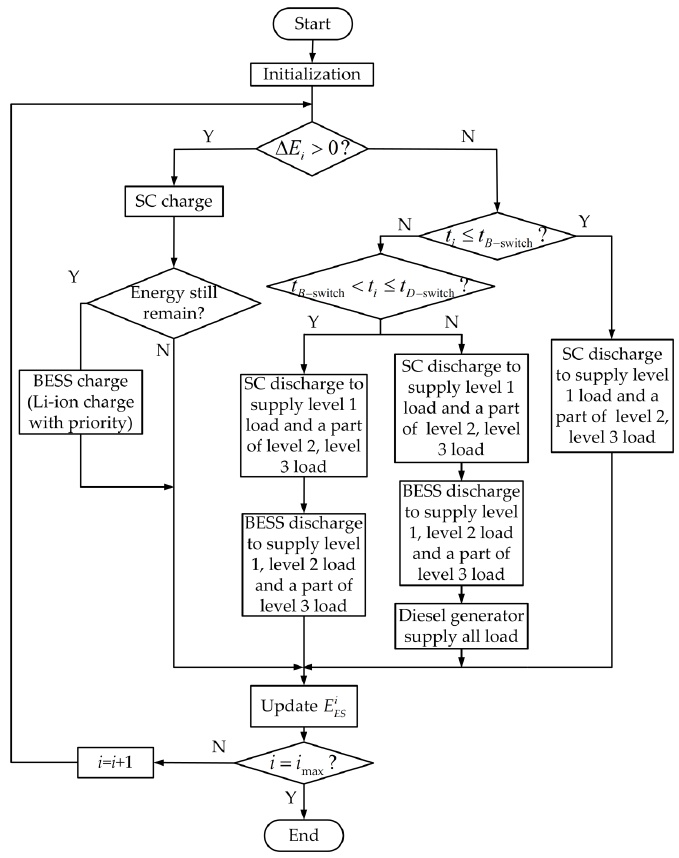
Figure 6. Flowchart of the planning